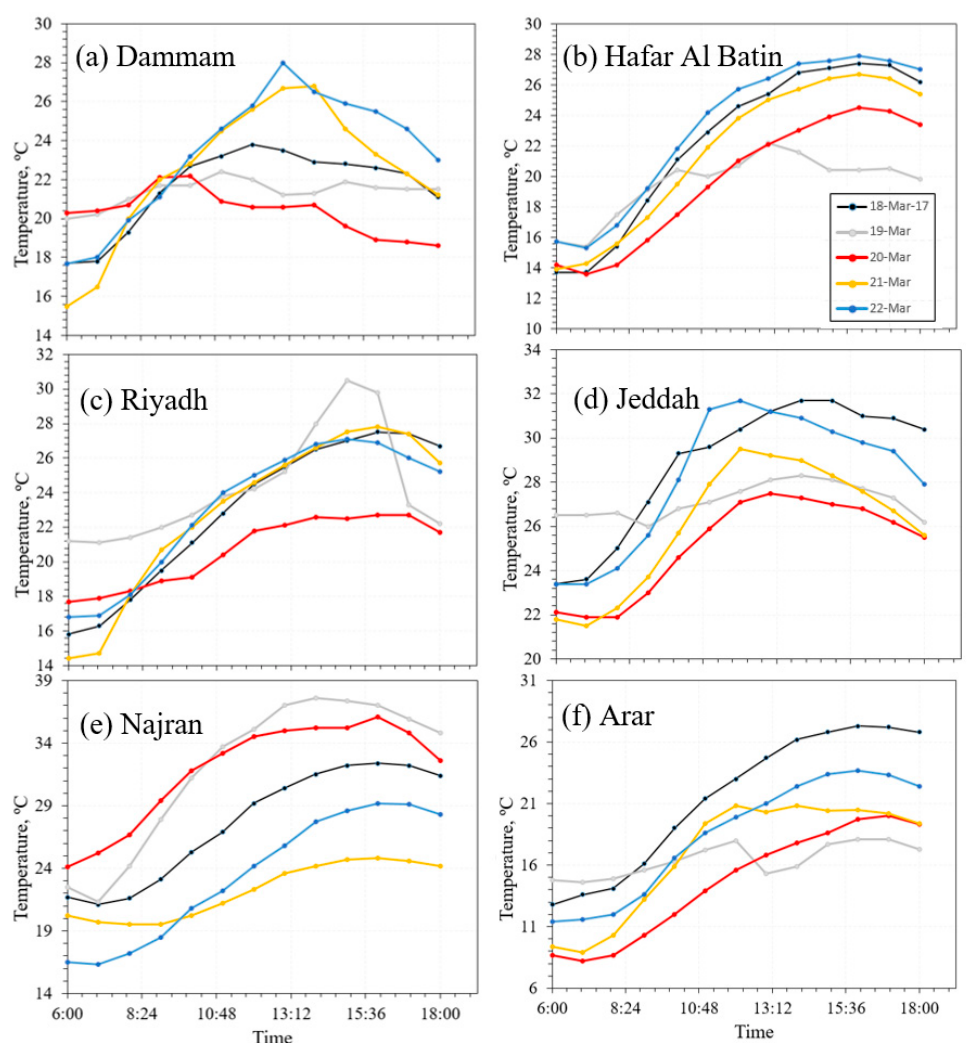
Figure 6. Air temperature variability ( ◦ C) over six Saudi cities ( a ) Dammam, ( b ) Hafar Al Batin, ( c ) Riyadh, ( d ) Jeddah, ( e ) Najran, and ( f ) Arar from 18 to 22 March 2017.